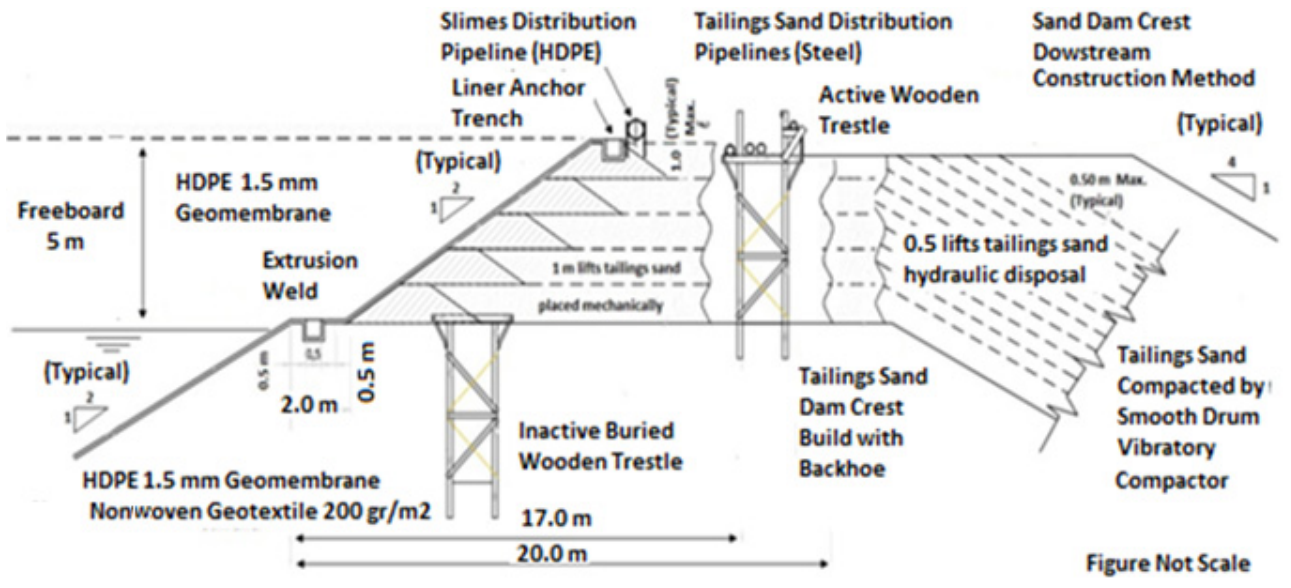
Figure 21. Cycloned tailings sand dam upstream face waterproofing construction detail.